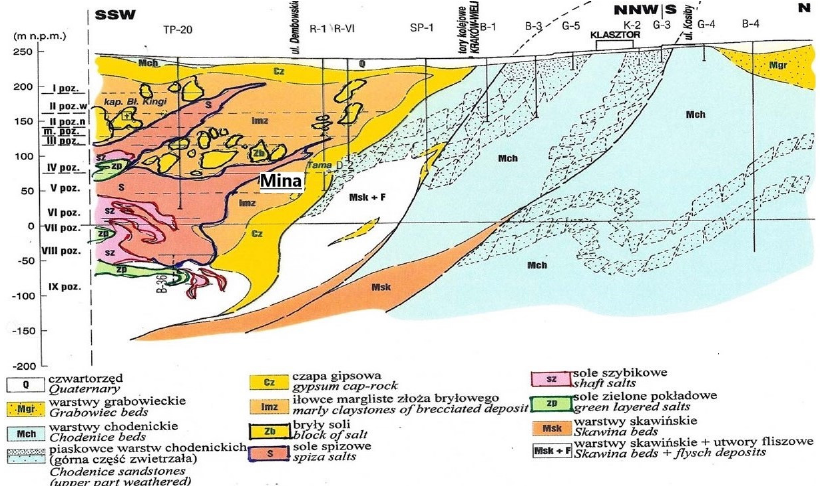
Figure 2. Geological cross-section through the northern part of the salt deposit in Wieliczka [9]. 2. Water Inflow through the Mine Workings Reaching the Ground Surface Most often, water from precipitation and underground tributaries enters the mines through leaks. They occur at the contact of the rock mass with the shaft casings, which are necessary for the proper operation of the mine, or with filling holes [8,9], which are used to fill selected mine workings with sand. One such facility was the Kosciuszko shaft, which is very important for the mine. It acts as a ventilation and exhaust shaft. The Kos- ciuszko shaft was built in the 18th century. Currently, its depth is 324 m, and it has a wall, barrel lining at the length from the core to a depth of 62.0 m, and a circular lining along the remaining length of the shaft pipe. The geological conditions around the Kosciuszko Shaft were determined on the basis of geological and engineering studies [10]. Such works are performed prior to the commencement of drilling works and on the basis of profiling of the core holes drilled from the shaft cellar in the axis of the anti-filtration partition (Ta- ble 1). The main argument in favor of choosing this shaft for the description in this article is the implementation of jet grouting technology. Additionally, this method is supple- mented by a pressure injection [11,12] to seal and strengthen the near-surface area of the casing with the use of a specially developed system for monitoring the casing’s behavior during injection works. Table 1. Separate generalized facies in the immediate vicinity of the Kosciuszko shaft [10]. Facies Designation